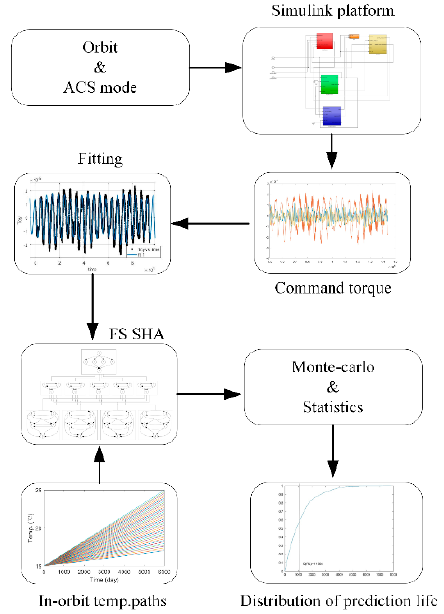
Figure 6. Simulation process.